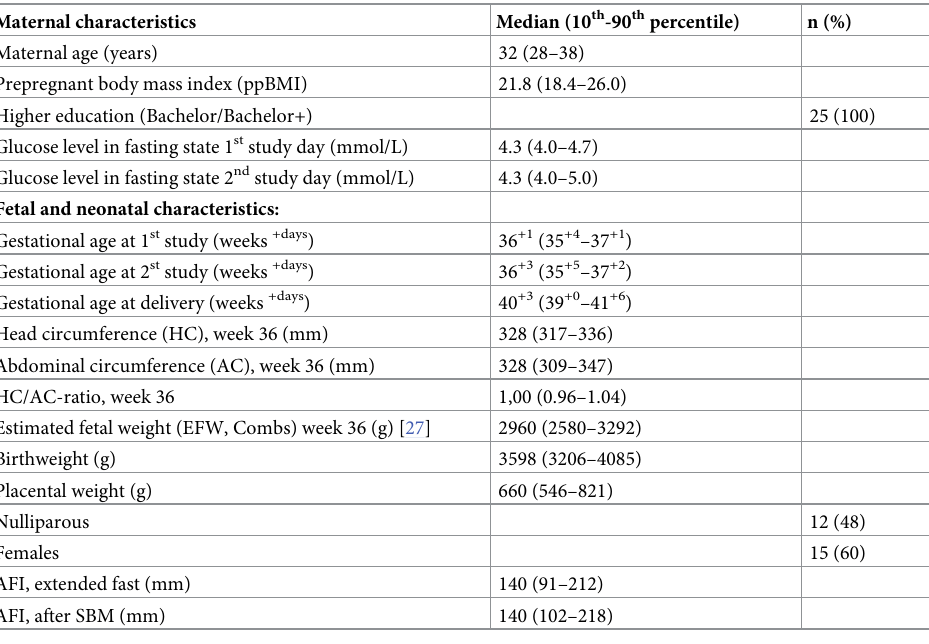
Table 1. Maternal, fetal and neonatal characteristics (n = 25). Maternal